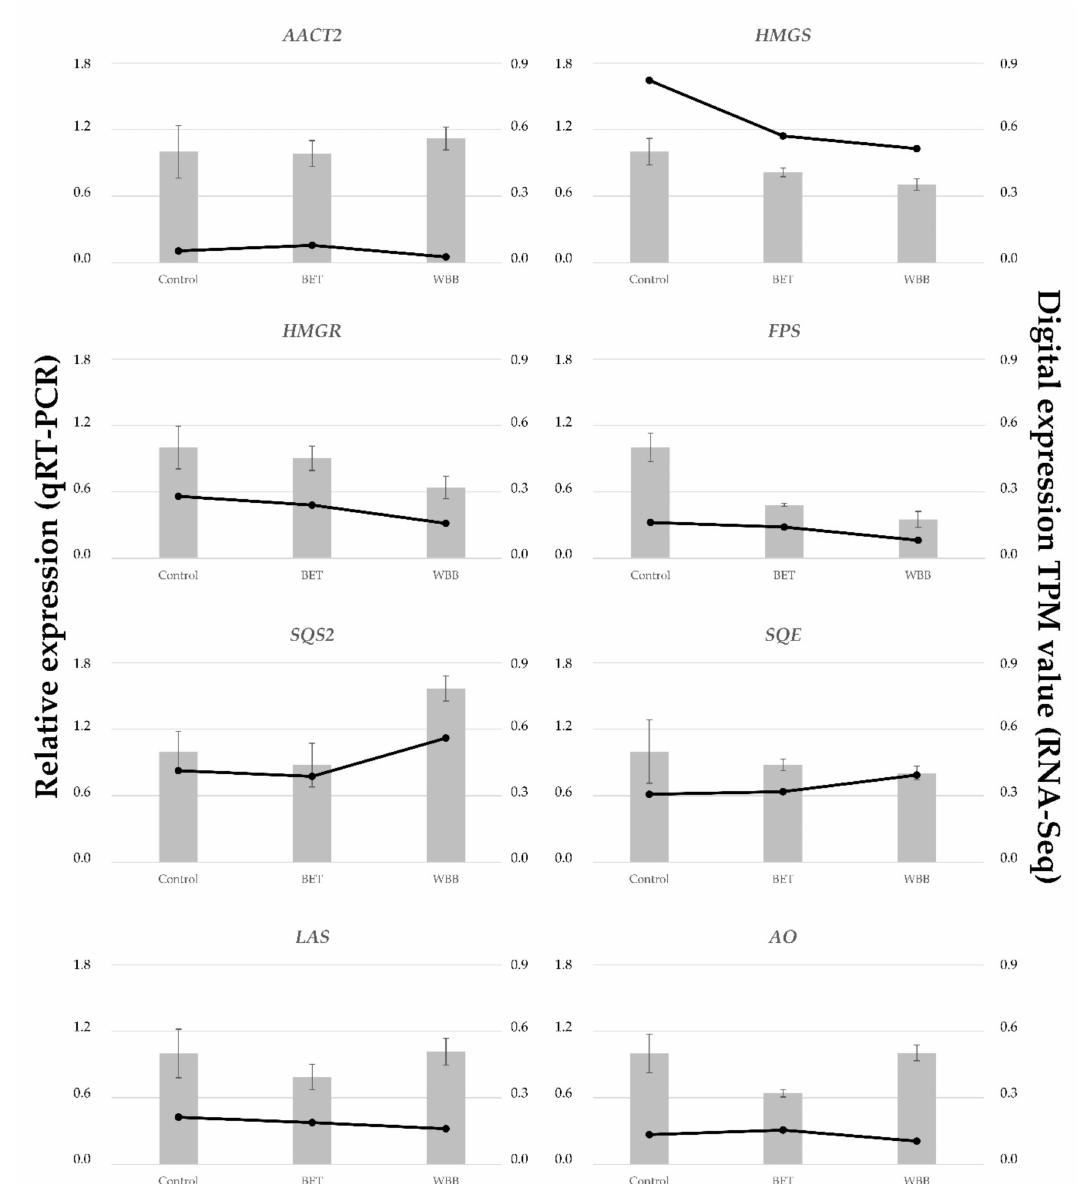
Figure 8. Comparison of expression profiles of eight representative transcripts from I. obliquus cells supplemented without (control) or with betulin (BET) or white birch bark (WBB), as measured by RNA-Seq and quantitative reverse transcription PCR (qRT-PCR). The eight transcripts are assigned to the terpenoid pathway in Appendix A—Figure A1. Columns represent expression determined by qRT-PCR (left y -axis), while lines represent digital expression by RNA-Seq in TPM values (right y -axis). The x -axis indicates di ff erent growth conditions (control, BET, and WBB). Graphs are plotted using normalized ddCt values scaled to control. Centromere protein 3 (CEN3) was used for internal reference. Expression fold change and error bars were calculated using the comparative 2 − ∆∆ Ct method [84]. Bars represent the mean standard deviation of three independent replicates. Abbreviations are defined in Appendix A—Figure